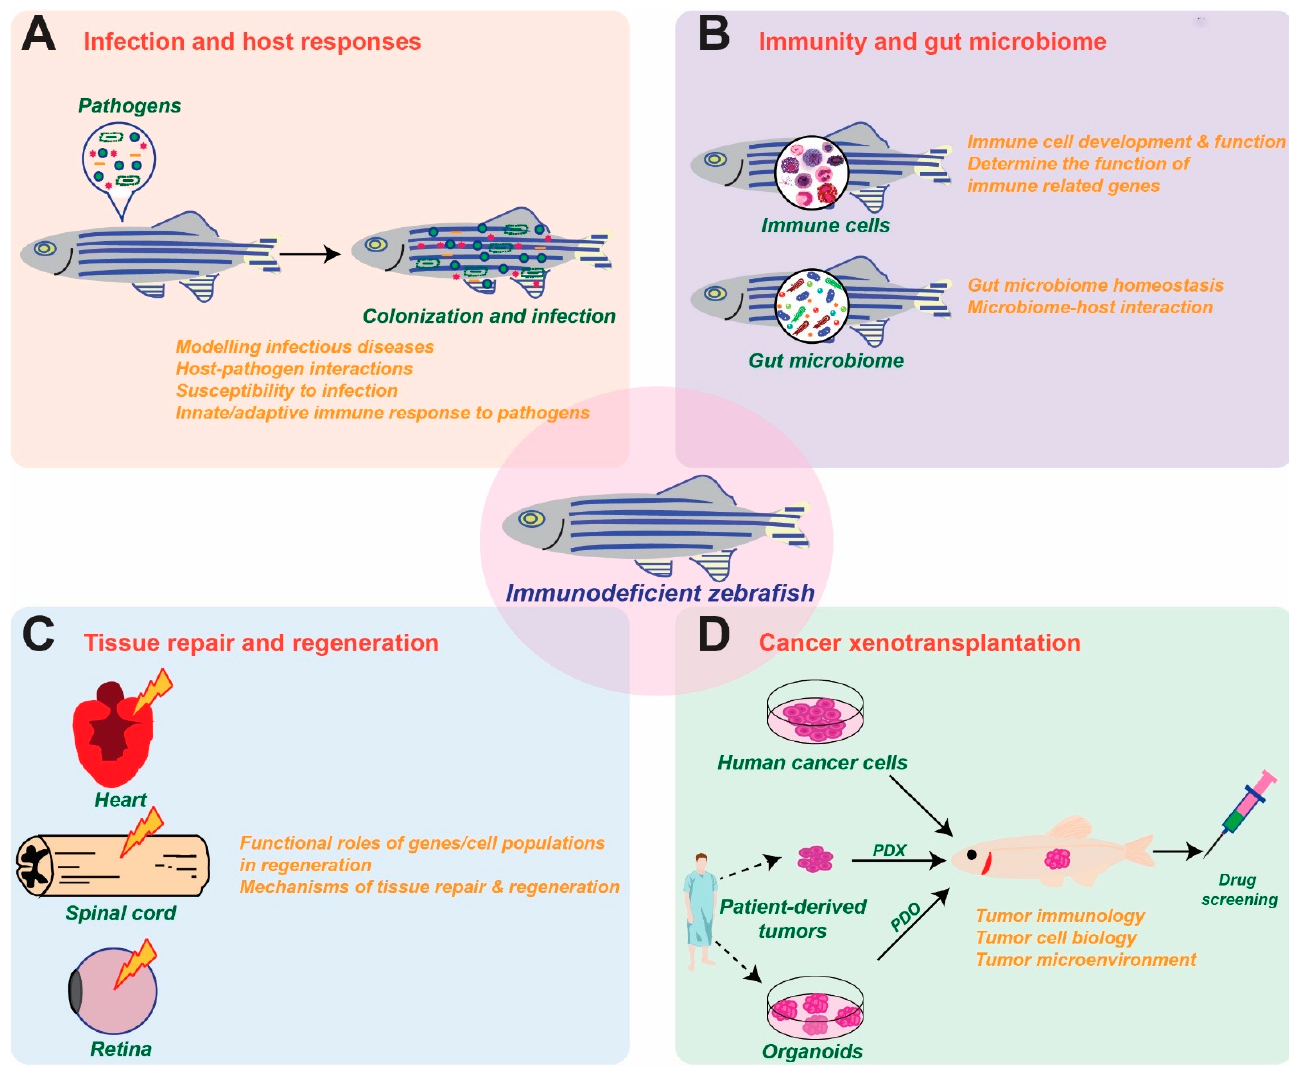
Figure 2. Applications of immunodeficient zebrafish models. Schematic diagrams of how immunodeficient zebrafish are being utilized to study infection and host responses ( A ), immunity and the gut microbiome ( B ), tissue repair and regeneration ( C ) and cancer xenotransplantation ( D ).